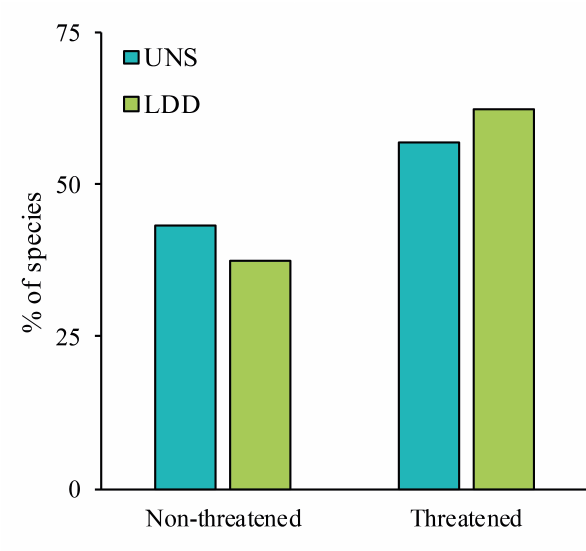
Figure 2. Number of species with (green) and without (blue) LDD syndromes in the endemic Canarian lowland flora (262 species). UNS: unspecialized (169 spp.), ANE: anemochorous (74 spp.); END: endozoochorous (8 spp.); DI: diplochorous (8 spp.); THA: thalasochorous (2 spp.); EPI: epizoochorous (1 spp.). (Online version in color).